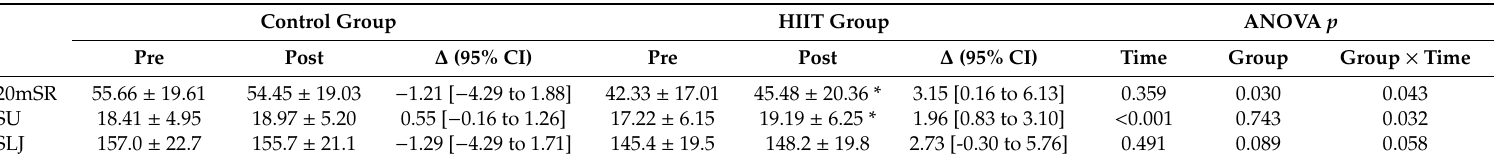
Table 2. Changes in physical fitness after training intervention.